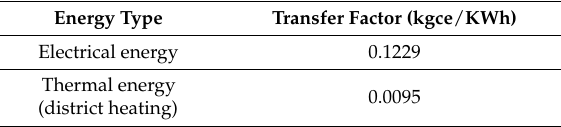
Table 3. The coal energy conversion factor.